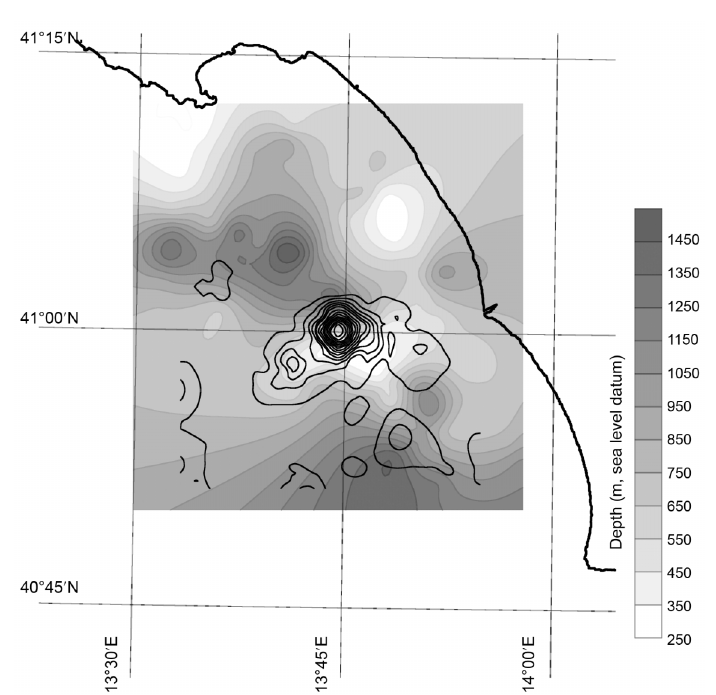
Fig. 10. Analytic Signal (2D) of the magnetic anomaly (thin line contour) and depth map of the top of the mag- netic source (gray textures). The mismatch between the two maxima is in the order of 1.5